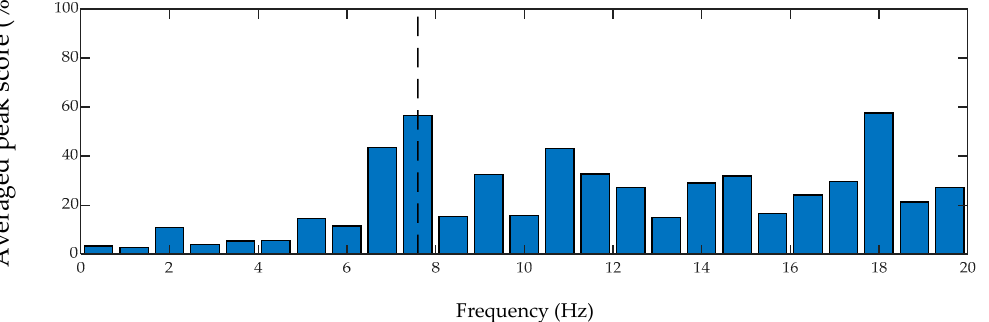
Figure 20. Histogram of averaged peak scores of unfiltered on-bridge spectrums.